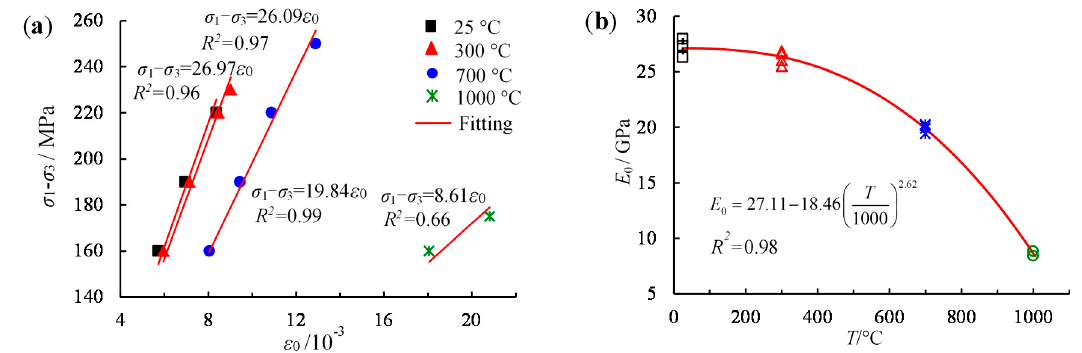
Figure 2. ( a ) Relation between the axial instantaneous strain and deviator stress and ( b ) Relation between the instant deformation modulus and temperature.